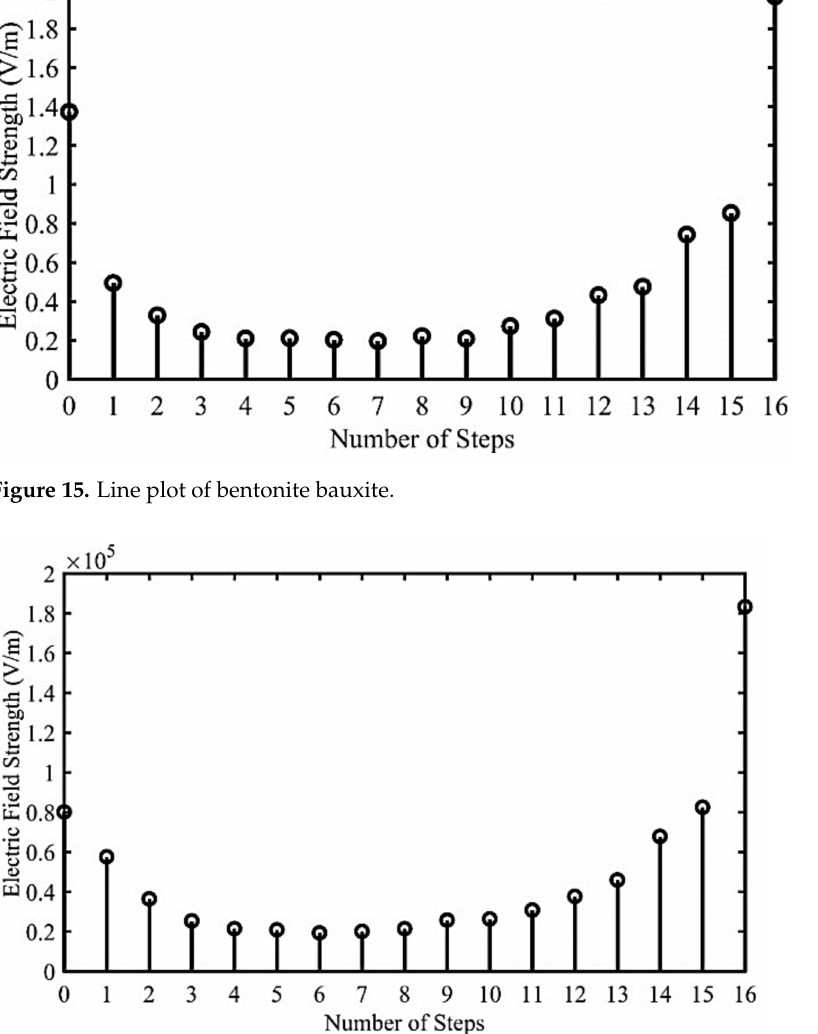
Figure 16. Line plot of bentonite china